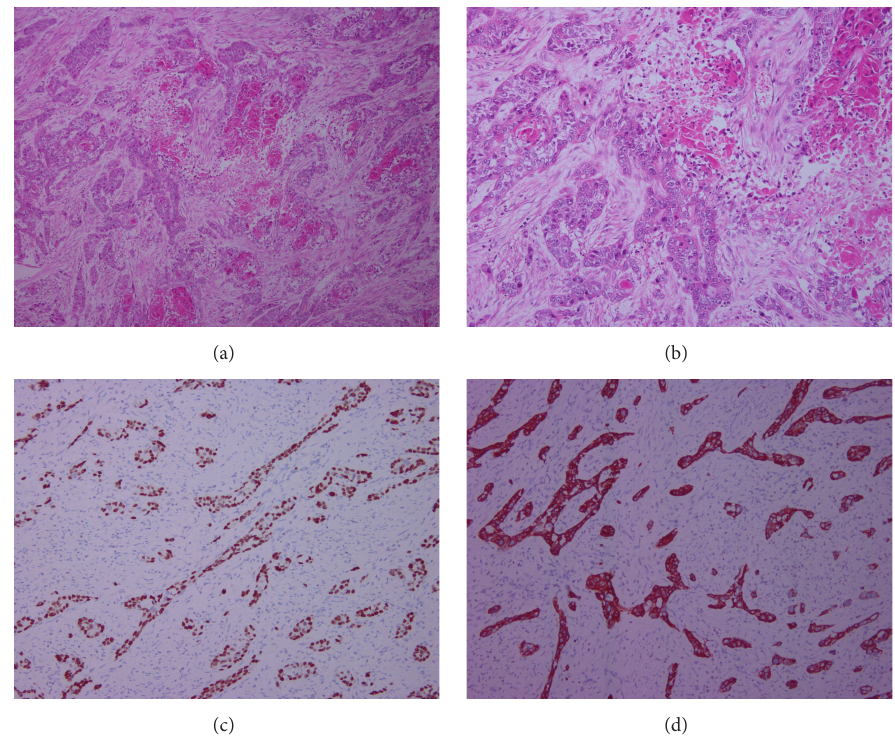
Figure 1: Pathological and immunohistochemical characteristics of squamous cell carcinoma ((a) hematoxylin-eosin staining, × 100; (b) hematoxylin-eosin staining, × 400); immunohistochemistry of p63 ((c) × 40) and CK5/6 protein ((d) × 100) that was positive in the squamous cell carcinoma area.